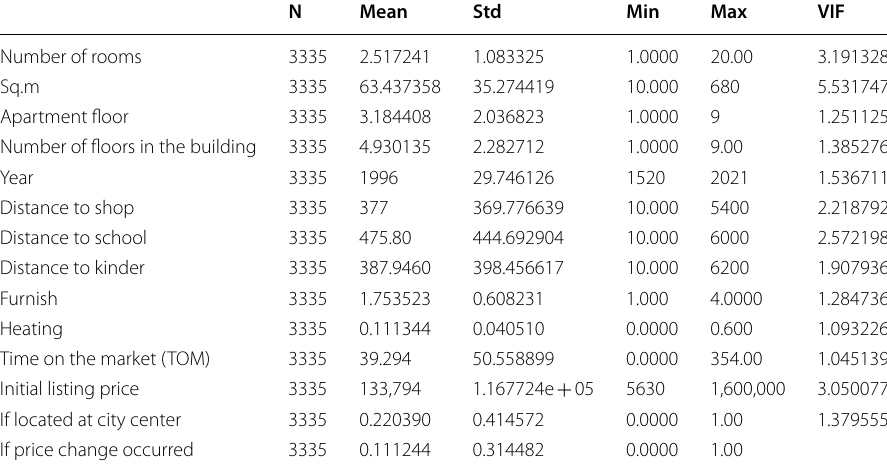
Table 7 Sample descriptive statistics for month June sell